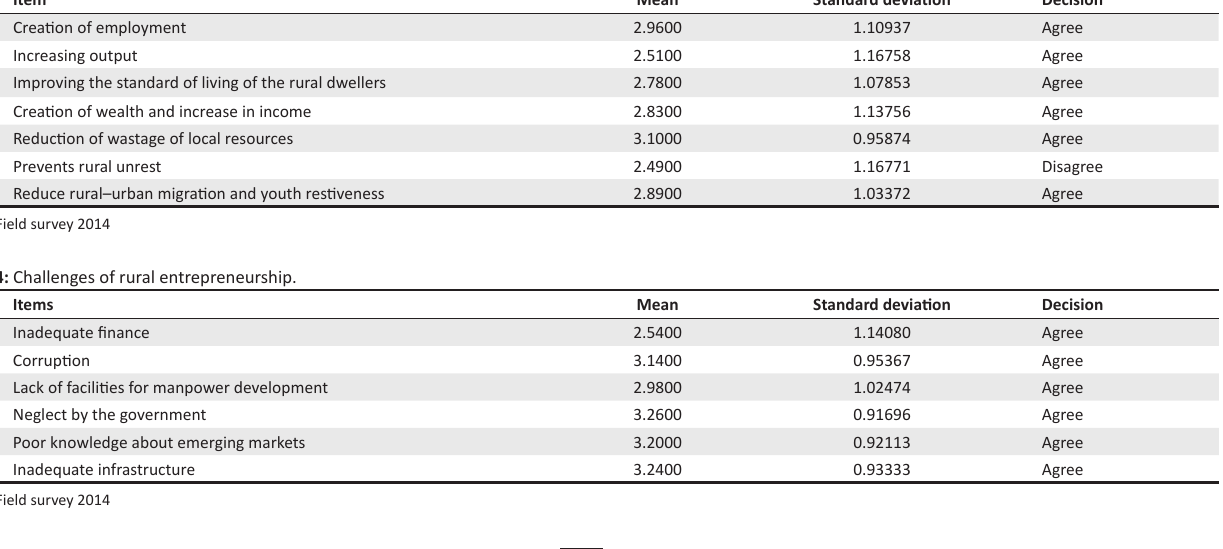
TABLE 3: The role of rural entrepreneurship in rural development ( n = 200). S/N Item